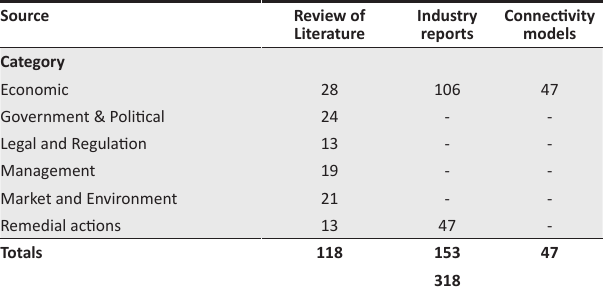
TABLE 1: Analysis of themes identified from non-interview sources (secondary